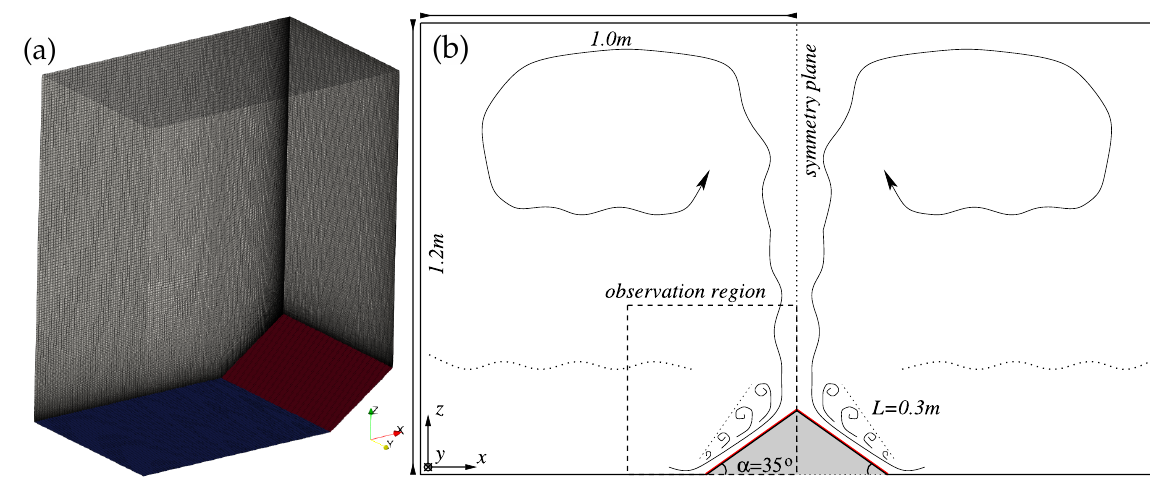
Figure 3. Outline of the case study geometry: ( a ) overview of the simulation domain and computational grid; ( b ) sketch of the full geometry and the main flow features, highlighting the observation region selected for the